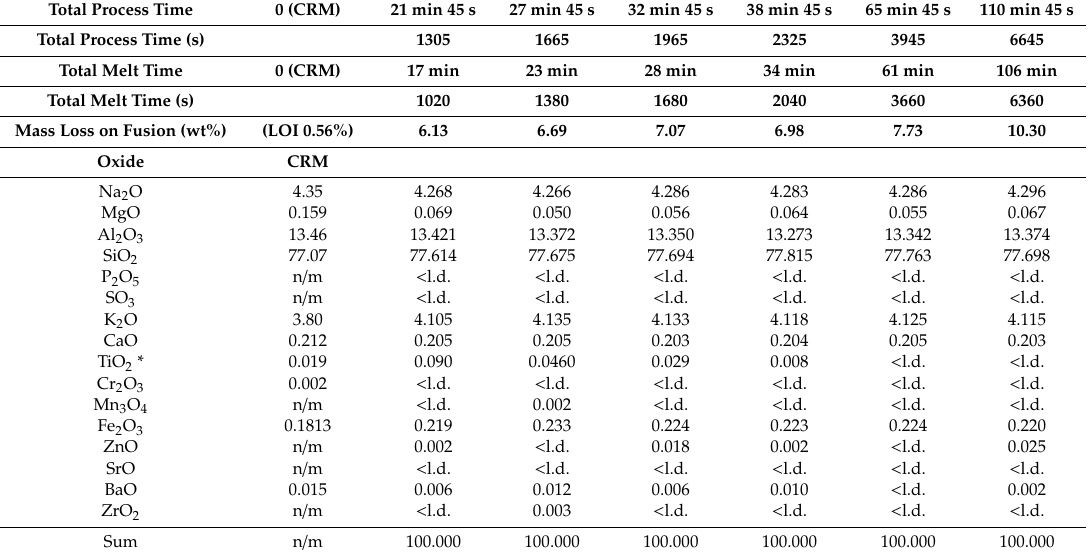
Table A2. XRF data for Swedish Feldspar (CRM-532, [42]) as a function of total process and melt times. Data are single measurements; < l.d. = below limit of detection; n / m = not measured; * analysed TiO 2 content includes contribution from I L β 1,2,3 lines.